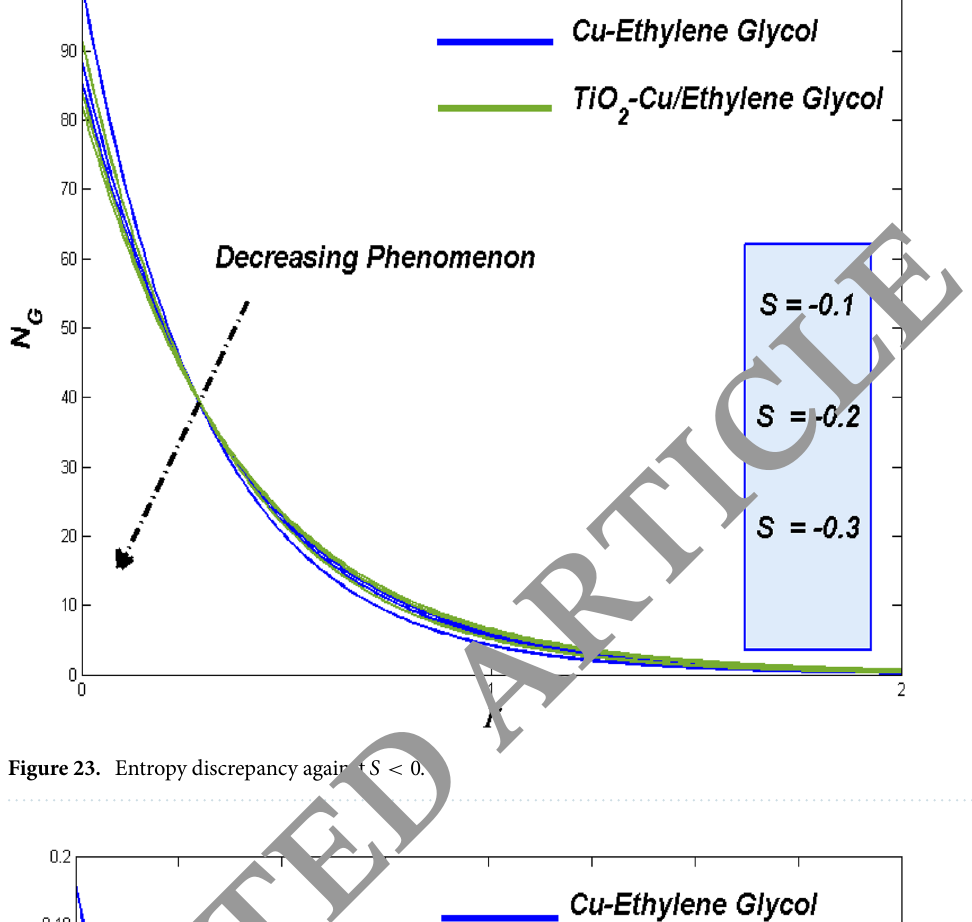
Figure 23. Entropy discrepancy against S < 0 .